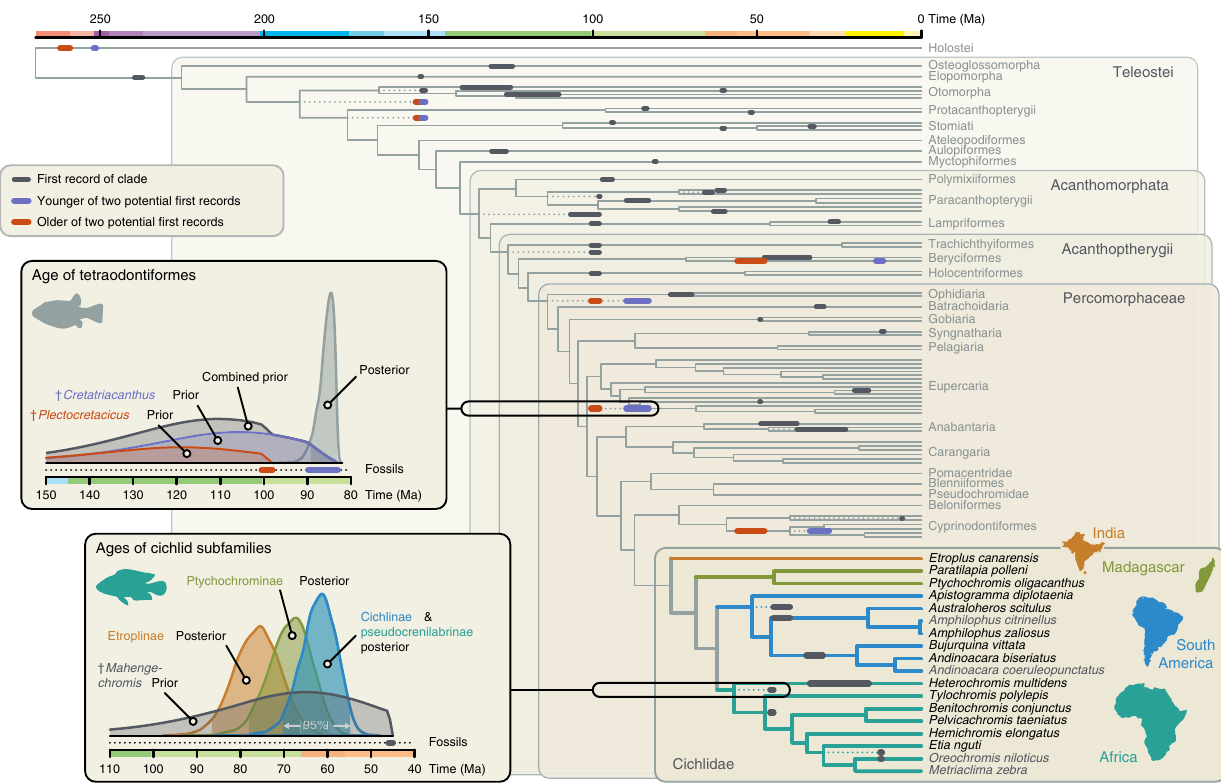
Fig. 2 The genomic timeline of cichlid and teleost diversi fi cation. The 14 cichlid species with new genome sequences are highlighted in bold. Fossils used for time calibration are marked on branches according to the fossil ’ s age and its uncertainty. For seven clades, the fi rst occurrence is ambiguous. In these cases, the younger and older of the two potential fi rst records are marked in purple and red, respectively. One example of such a clade, Tetraodontiformes, is shown in the fi rst inset. Either † Cretatriacanthus guidottii (89.8 – 83.0 Ma) or † Plectocretacicus clarae (100.3 – 98.0 Ma) represent the fi rst record of this clade. Our new model for time calibration with ambiguous fi rst records calculates separate CladeAge prior densities for both fossils (shown in purple and red) and forms a combined prior density (shown in dark gray) based on these. The resulting genomic age estimate (posterior; shown in light gray) indicates that Tetraodontiformes are younger than † Plectocretacicus and thus supports † Cretatriacanthus as the fi rst record of the group. The CladeAge prior density for the oldest cichlid record, † Mahengechromis , and the age estimates for the four cichlid subfamilies are shown in the second inset. A version of this phylogeny with all tip labels is provided in Supplementary Fig. 6. Table 1 Age estimates for selected clades, obtained with different settings and datasets. Setting/Dataset